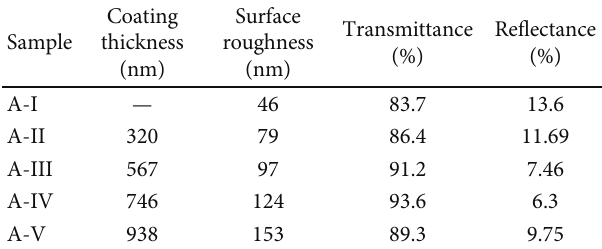
Figure 7: Re fl ectance of bare cell and MoS Table 3: Observed transmittance and re fl ectance percentage of bare and coated solar cells.